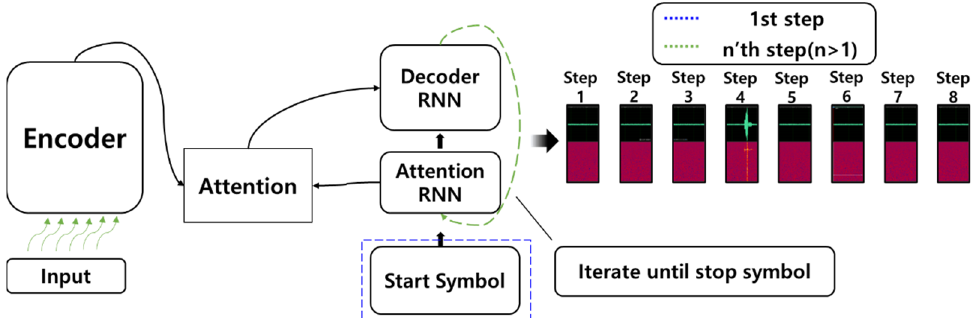
Figure 5. Model structure of the proposed sonar signal synthesis.